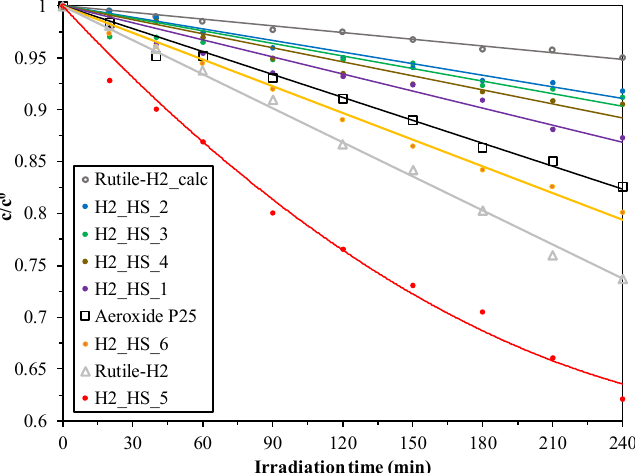
Figure 11. Photocatalytic decomposition of phenol solutions under visible light irradiation (c phenol = 0.1 mM, c TiO2 =1.0 g∙L −1 ).